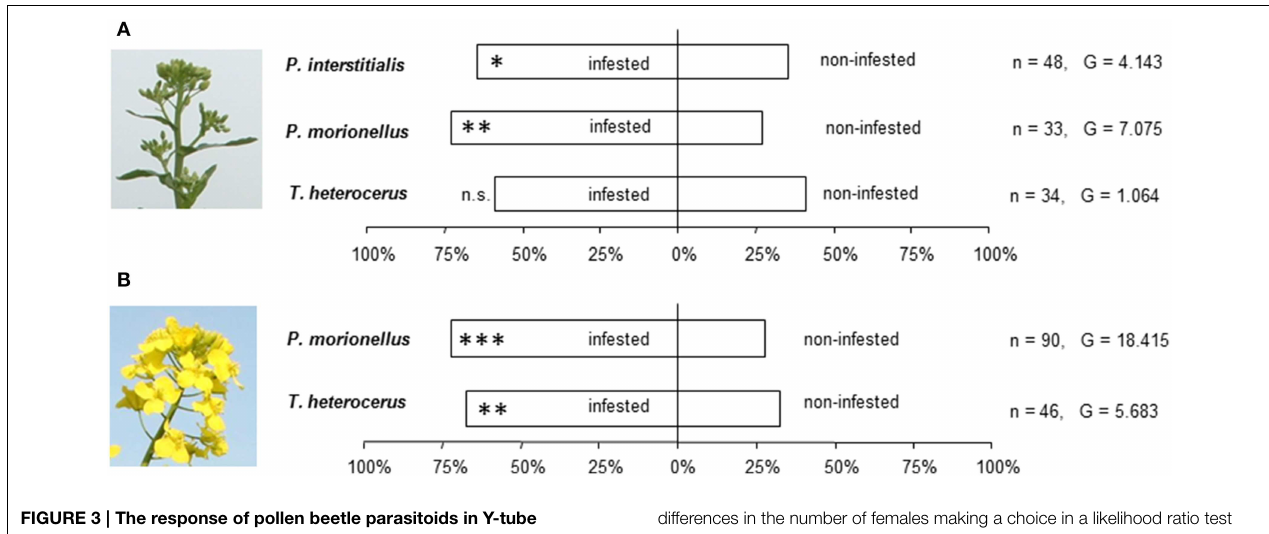
FIGURE 3 | The response of pollen beetle parasitoids in Y-tube experiments to odors from infested and non-infested oilseed rape. (A) Bud stage. (B) Flowering stage. Asterisks indicate statistically significant